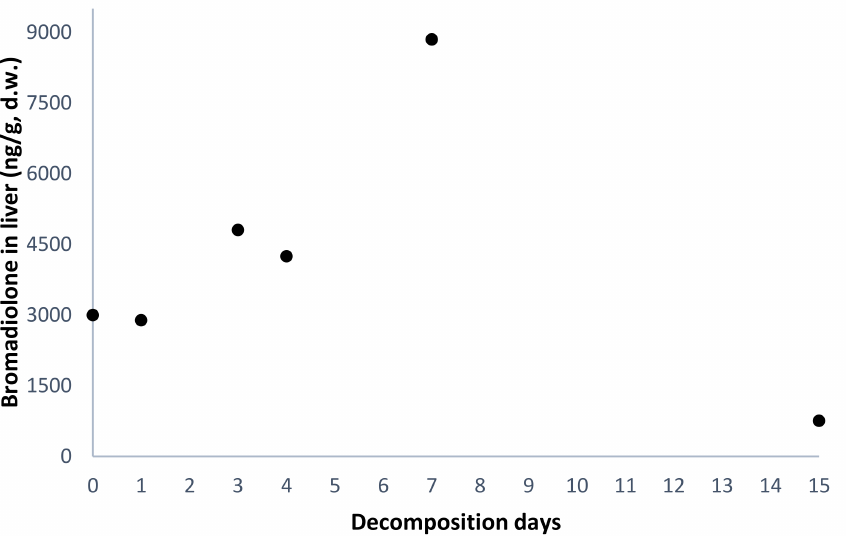
Figure 3. Bromadiolone concentration in liver (ng / g, d.w.) relative to the carcass decomposition time (days) in dosed common kestrel ( r = − 0.20, p = 0.699, n =